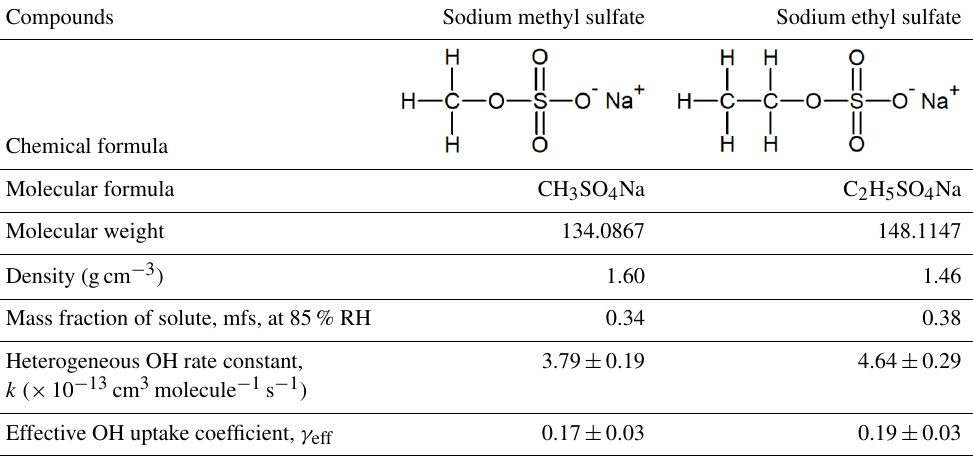
Table 1. Chemical structures, properties, rate constant, and effective OH uptake coefficient of sodium methyl sulfate and sodium ethyl